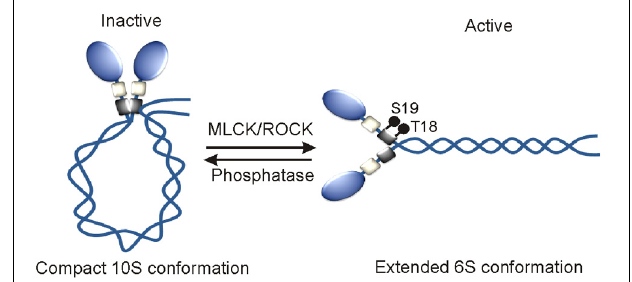
FIGURE 2 | Mechanism of the activation of myosin II motor proteins. RLC phosphorylation by MLCK and ROCK or other kinases turns on myosin II motor protein in vivo